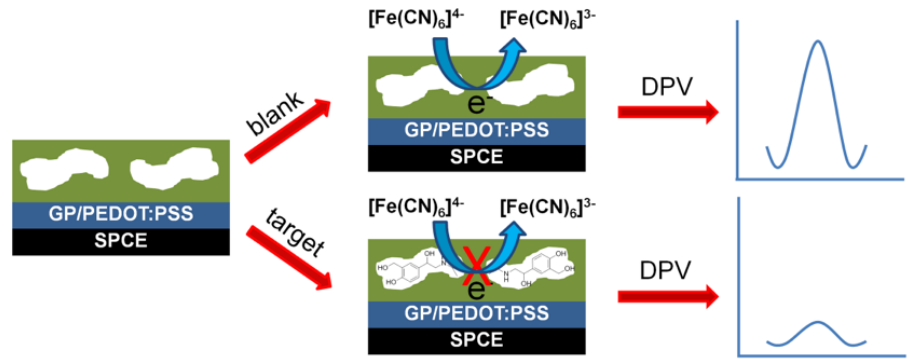
Figure 5. Schematic illustration of the electrochemical determination of salbutamol using an eMIP sensing platform. Reproduced from [105]—Published by The Royal Society of Chemistry.